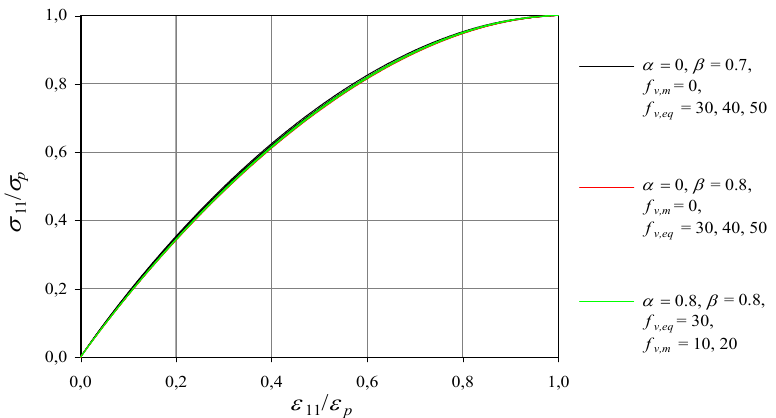
Figure 2: Dimensionless stress-strain curves of concrete in uni-axial